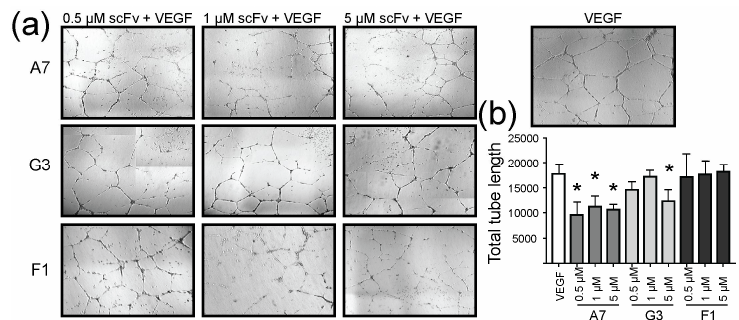
Figure 4. ScFvs inhibit VEGF-induced development of tube-like structures in HUVECs. ( a ) Microscopy images at 4× magnification show tubular structures formed in the presence of VEGF. Tube formation was disrupted in the presence of increasing concentrations of scFvs; ( b ) Image analysis quantifies the length of ligand-induced tubes in the presence and absence of scFv antibody fragments. Presented results are mean of three independent experiments, where error bars represent ± standard deviation (SD). The statistical significance was investigated with ordinary 1-way ANOVA using Dunnett’s test and indicated by * representing p < 0.05.